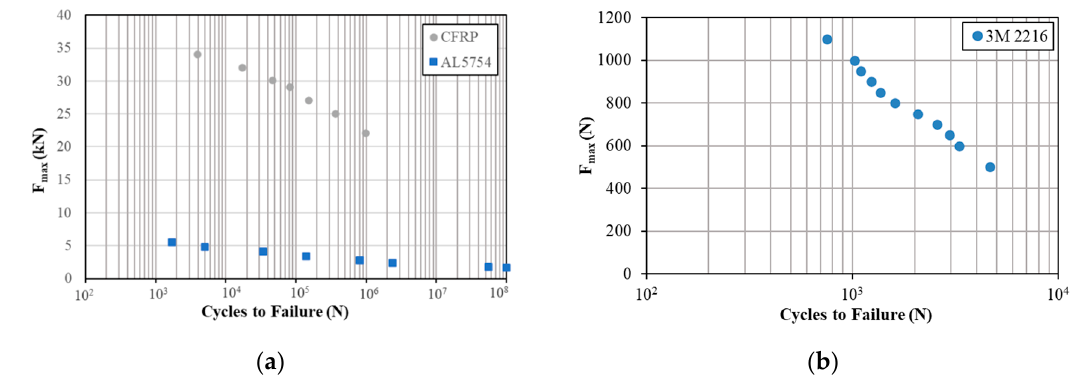
Figure 4. Stress vs. Cycles to failure graphs for the materials used: ( a ) Aluminum Alloy and CFRP; ( b ) 3M 2216 adhesive.